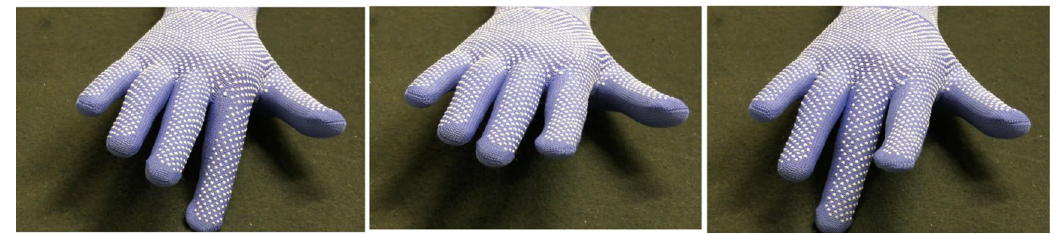
Figure 2. Example frames from the videos used in the automatic imitation